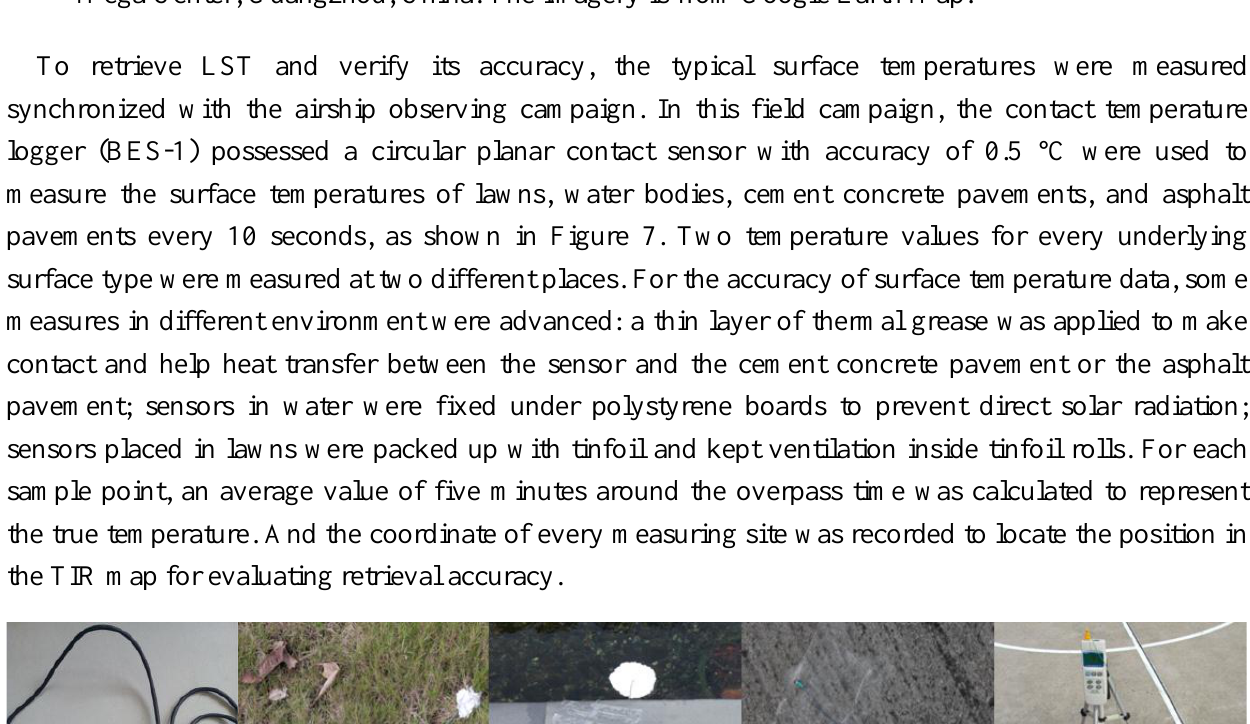
Figure 6. Study area: the Guangzhou university campus in Guangzhou Higher Education Mega Center, Guangzhou, China. The imagery is from Google Earth Map.